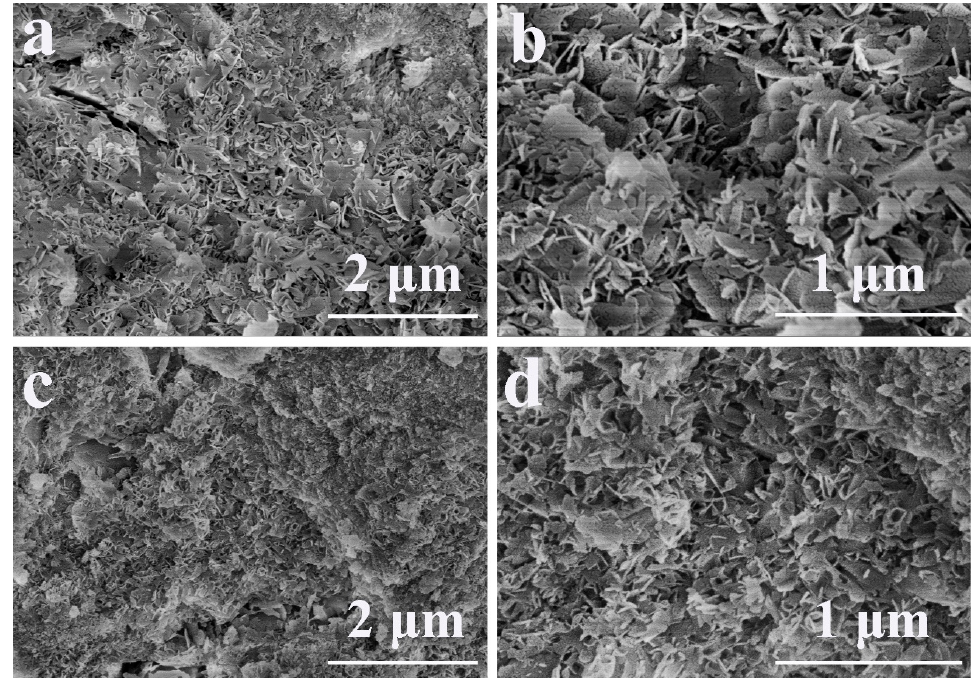
Figure 13 . The microstructure of sample CPC after soaking for three days ( a , b ) and sample CPC-20 after soaking for three days ( c , d ).